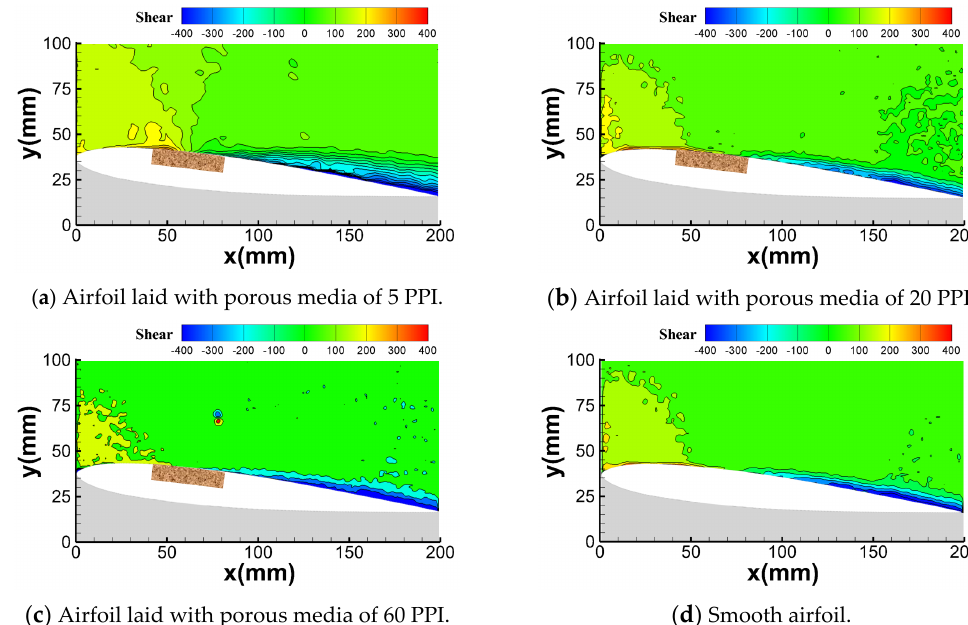
Figure 10. Time-averaged results of shear stress field (AOA = 6).